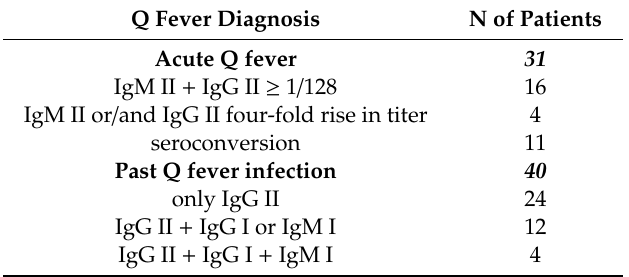
Table 2. Patients with a serology diagnostic of Q fever. The designations I and II indicate either phase I or phase II of C. burnetii ,